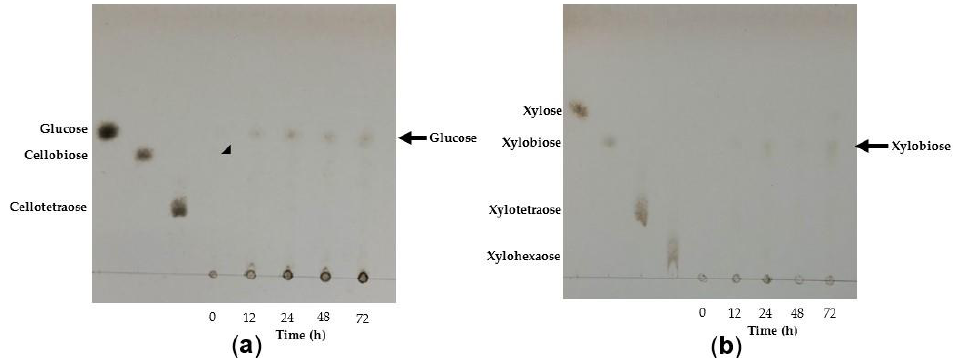
Figure 8. TLC analysis of the hydrolysis products released by the action of TtCel7A at 40 ◦ C from ( a ) CMC, ( b ) beechwood xylan at 1% concentration after 12 to 72 h incubation.